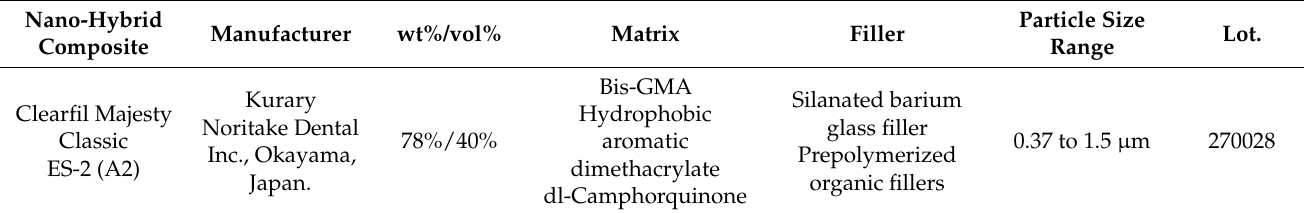
Table 1. Composition of the nano-hybrid resin-based